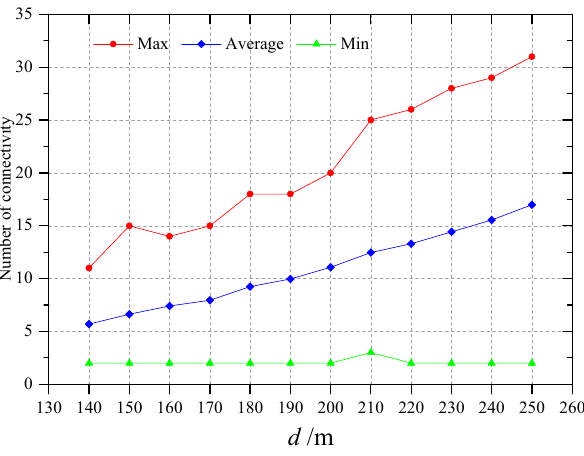
Figure 19. Network connectivity for different values of d .